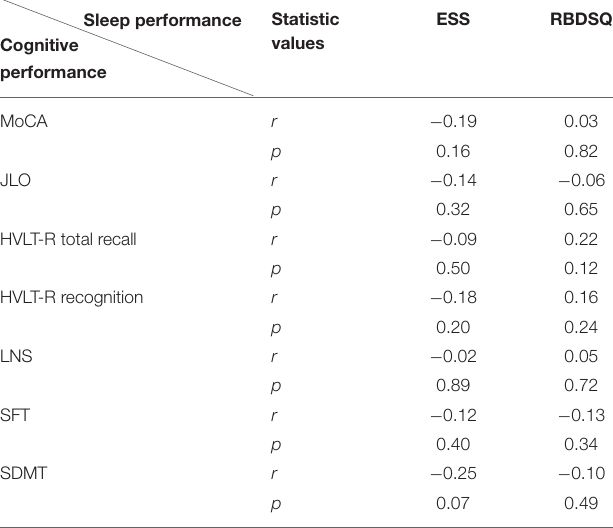
TABLE 3 | Correlations between cognitive performance and sleep performance in patients with PD-pRBD + by combining visit times. Sleep Cognitive